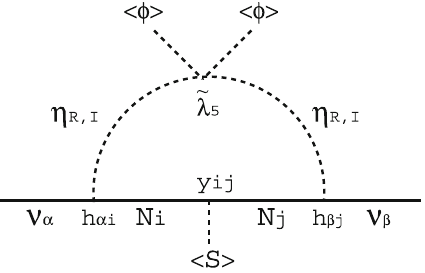
Fig. 1 The one-loop diagram for the neutrino mass generation, in which η R and η I are a real and an imaginary part of the neutral com- ponent of η , respectively